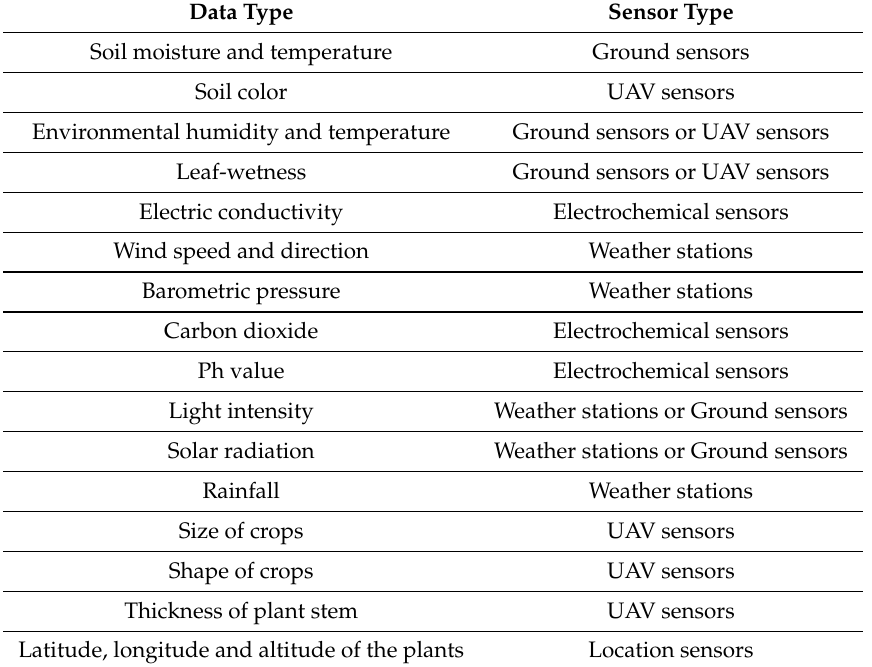
Table 1. Precision agriculture sensor data